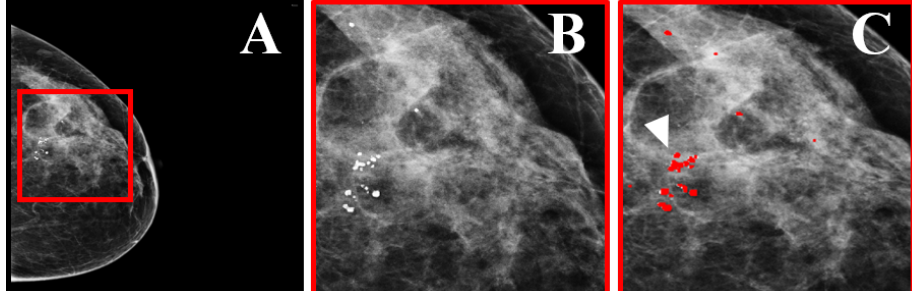
Figure 8. Dataset example. ( A ) Mammographic view of a woman with benign and suspicious MCs. ( B ) Zoomed region marked by the red square in ( A ), showing the MCs. ( C ) The region in ( B ) with precise marking of the MC locations (indicated by the white arrow), as annotated by two expert radiologists (reprint with permission from